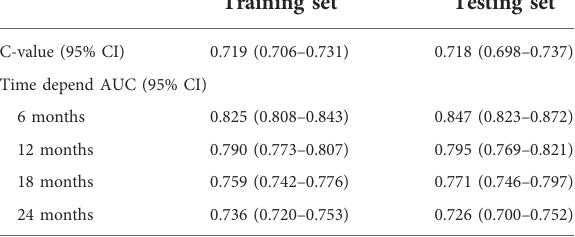
TABLE 5 The predictive values of the prediction model. Training